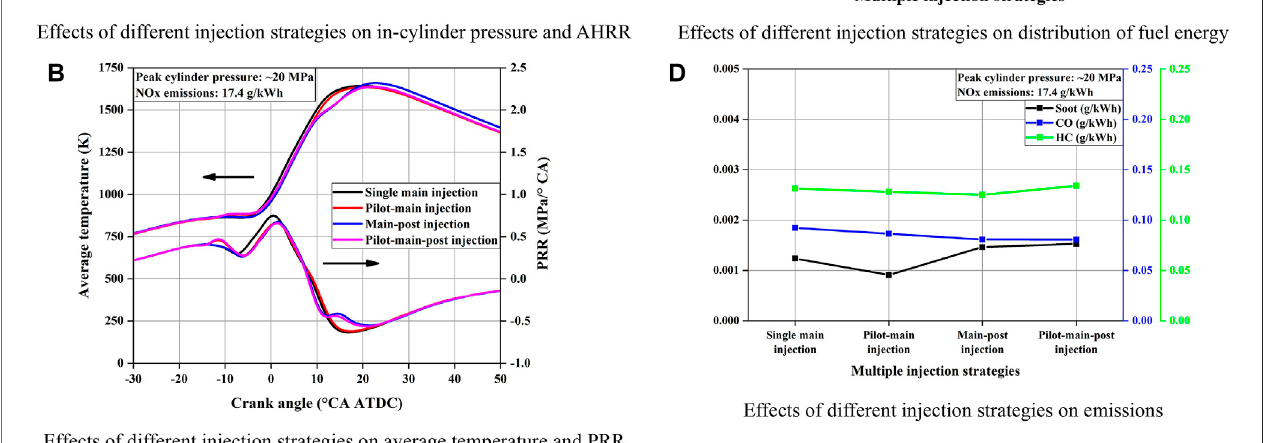
FIGURE 14 | Effects of different injection strategies on performance at a given NOx emission of 17.4 g/kWh and approximate 20 MPa PCP. (A) Effects of different injection strategies on in-cylinder pressure and AHRR, (B) Effects of different injection strategies on average temperature and PRR, (C) Effects of different injection strategies on distribution of fuel energy, (D) Effects of different injection strategies on emissions.